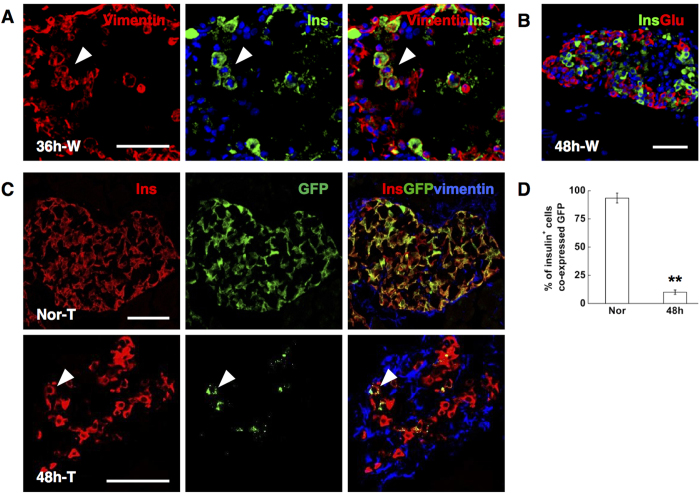
Conditional beta-cell lineage tracing.(A) Representative islets stained with antibodies against insulin (green) and vimentin (red) of wild-type mice at 36 hrs post STZ injection (36h-W). Nuclei were labeled with DAPI. Scale bars, 50 μm. The isosceles triangle: round-shaped vimentin+ cells gaining insulin expression at 36 hrs. (B) Photomicrographs double stained with anti-insulin (green) and anti-glucagon (red) antibodies of wild-type mice at 48 hrs after STZ injection (48h-W). Nuclei were labeled with DAPI. Scale bars, 50 μm. (C) Representative islets stained with antibodies against insulin (red) and vimentin (blue) of transgenic mice at 48 hrs post STZ injection (48h-T). The isosceles triangle: insulin+ cells showing GFP expression. Scale bars, 50μm. (D) Proportion of GFP+ beta-cells, as a percentage of insulin+ cells. Data are shown as means ± SEM, n = 3 per group; **P < 0.01.